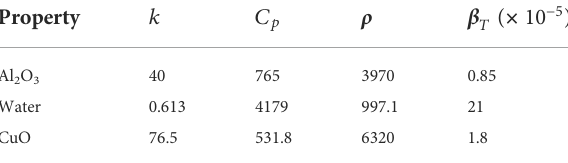
TABLE 2 Validation of the code for − θ 9 ( 0 ) with respect to some reduced